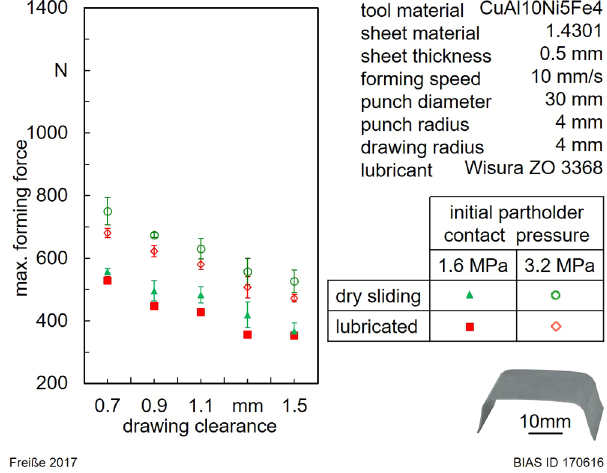
Fig. 11. Maximum forming forces using bronze tool under variation of the drawing